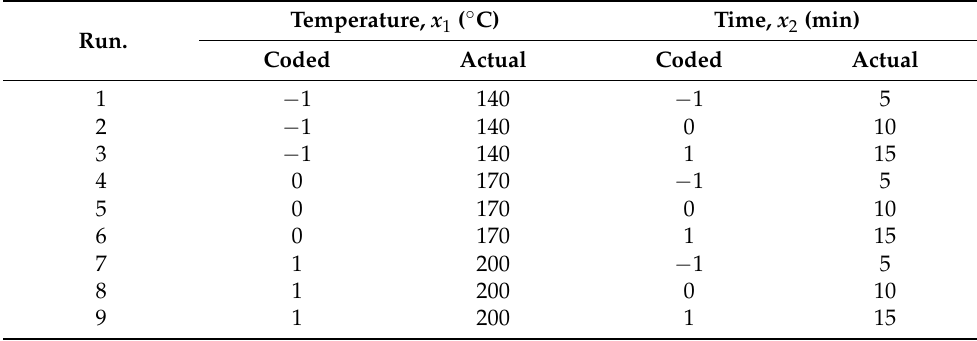
Table 1. Experimental design including the factors of frying process and their levels. Run.